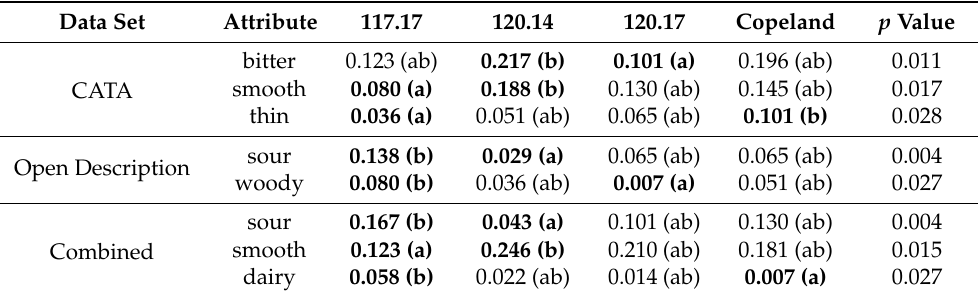
Table 5. Independent comparison of genotypes for each attribute using Cochran’s Q test. Only attributes with significant p values (alpha = 0.05) are included. Multiple pairwise comparisons using the critical difference (Sheskin) procedure allows separation of the genotypes by attribute. Cell values represent the proportion of citation frequencies. Values within a row that do not share a letter are significantly different (bolded for emphasis). Data Set Attribute 117.17 120.14 120.17 Copeland p